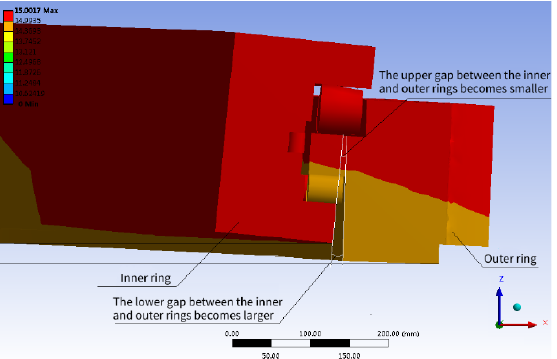
Figure 13. Different displacements exist between the inner ring and outer ring of the slewing sup-